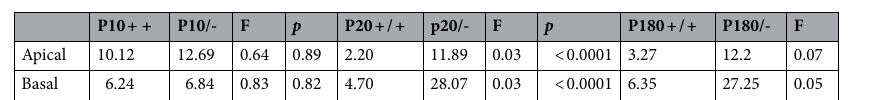
Table 2. Differences between slow axis of orientation in wild type and Emilin2 −/− BM. Slow axis of orientation was measured in the apical and basal regions of emilin +/+ and emilin −/− BM and SD were compared, as a measure of fiber disarrangement. The disorganization of the collagenous elements −/− BM as reflected in SD. The comparison between different ages in emilin +/+ and emilin −/− were made, as reflected in reported F and p